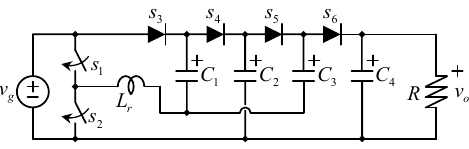
Figure 32. Topology studied in [109].